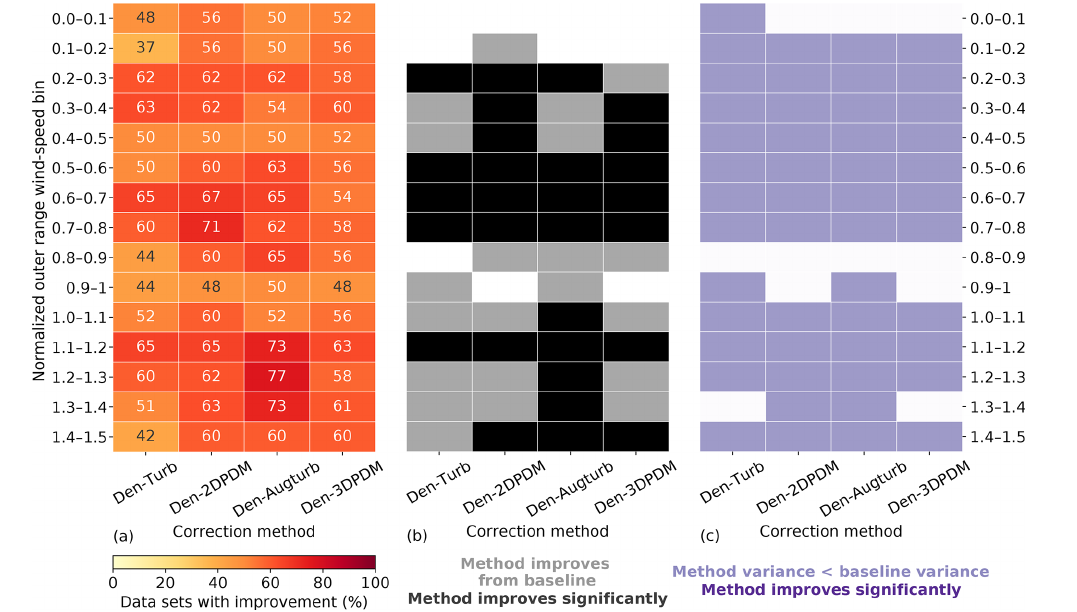
Figure 11. As in Fig. 10, but for the normalized wind speed bins in the outer range.